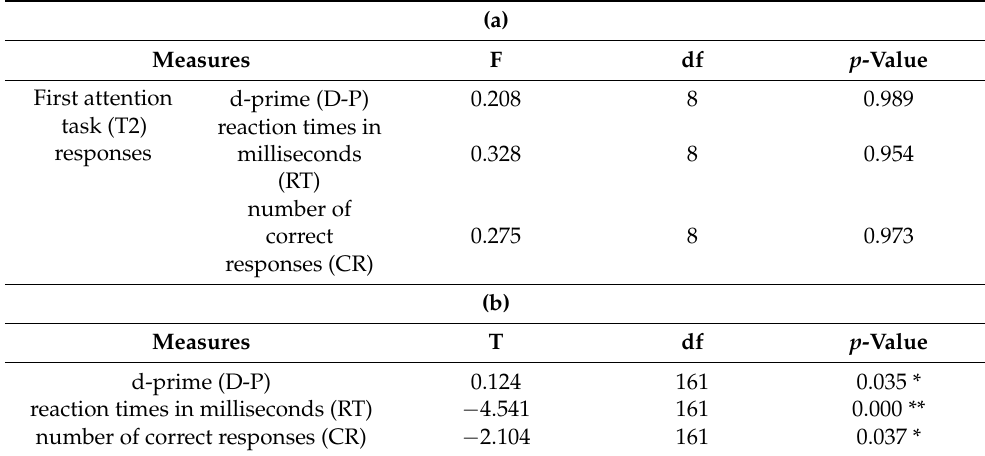
Table 3. ( a ) Test statistics from ANOVA on whether attention levels after the first SART were similar. ( b ) Test statistics from paired t-test tests on whether participants’ attention levels after the second SART differed from the first